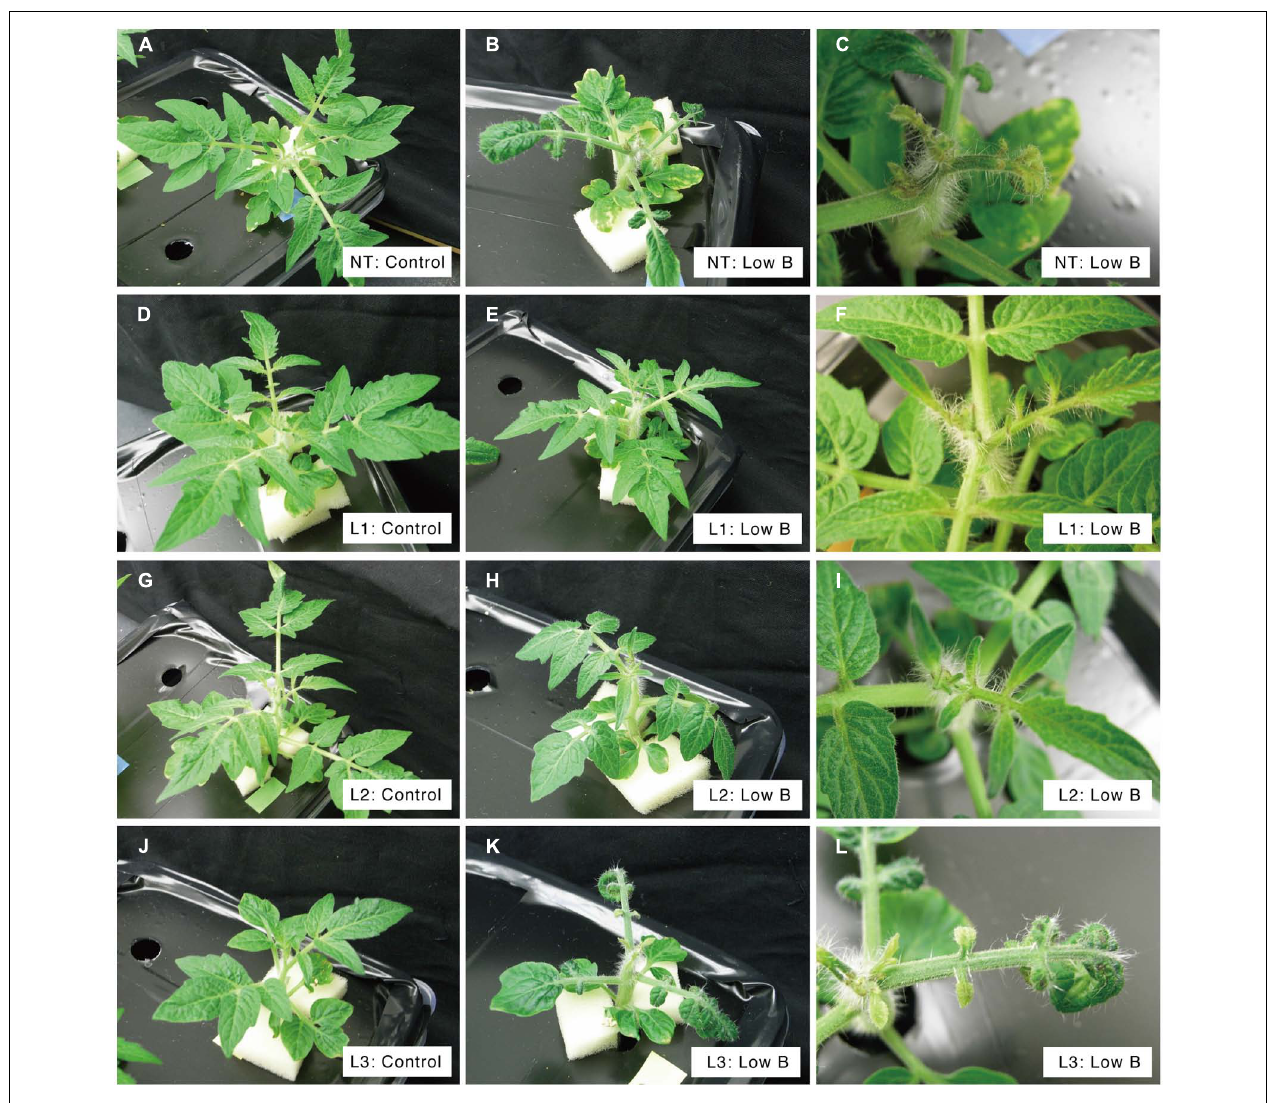
FIGURE 2 | Shoot development of transgenic tomato plants expressing AtBOR1 under B-deficiency and sufficiency. Non-transgenic (NT) plants (A–C) , transgenic plants L1 (D–F) , L2 (G–I) , and L3 (J–L) were grown for 15 days with a hydroponic solution